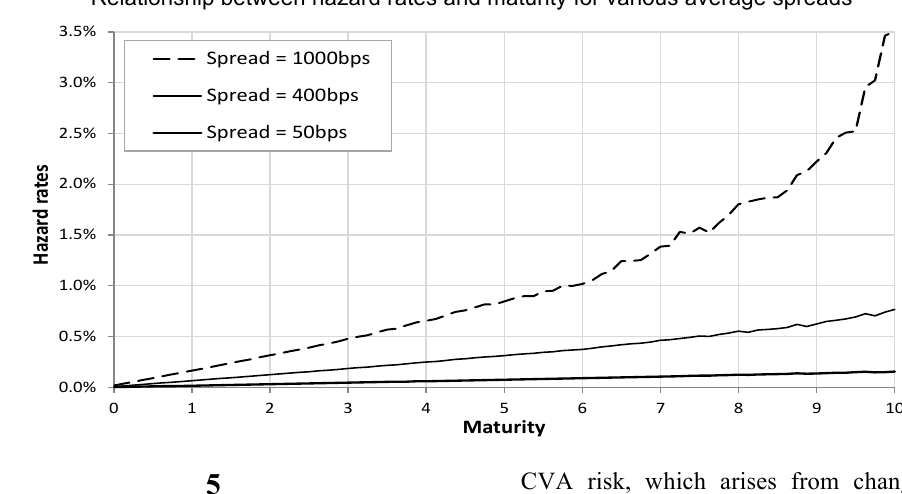
Relationship between hazard rates and maturity for various average